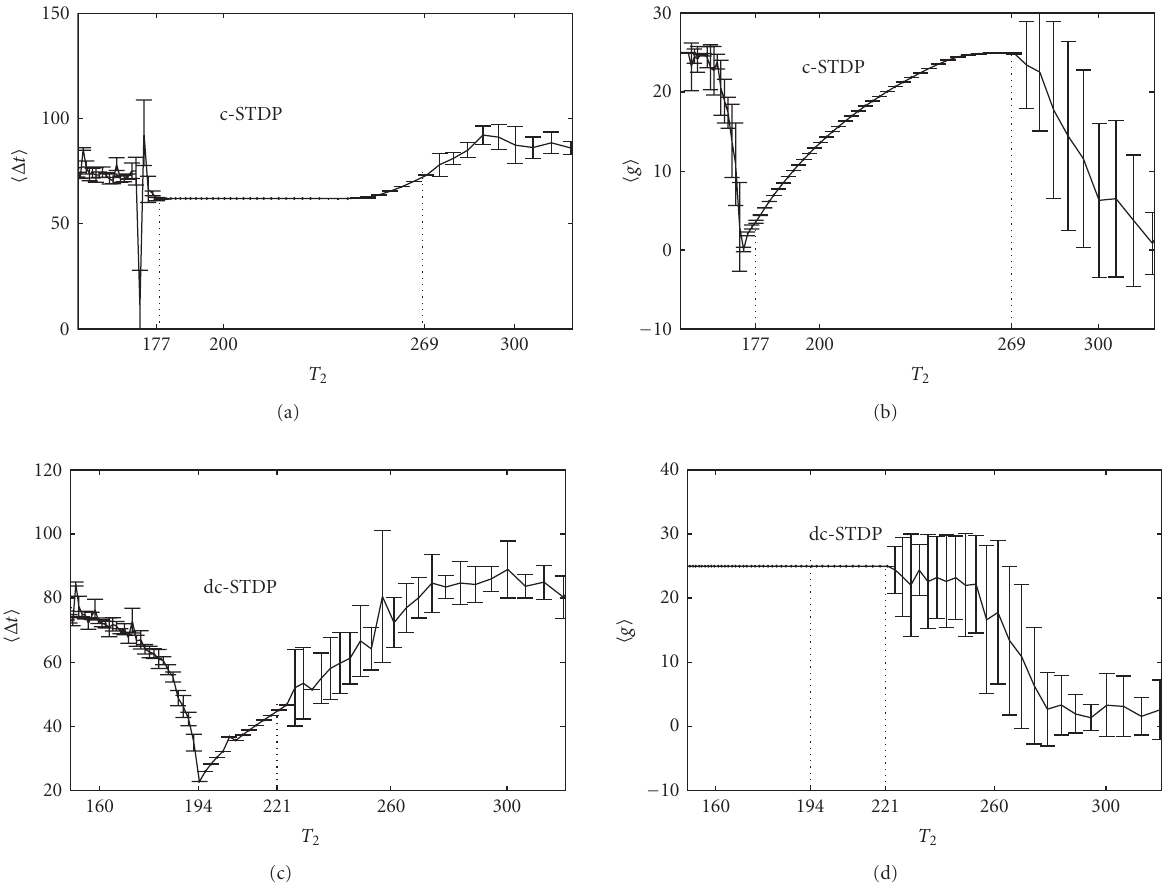
Figure 7: Four pictures are obtained from the same values of parameters and model of Figure 3. The front four pictures take the function of tanh to limit synaptic strength for c-STDP and dc-STDP rules. Figures 7(a) and 7(c) show the average spike time interval of postneuron’s and preneuron’s spike time for c-STDP and dc-STDP over some time after a period time of coupling, respectively. Figures 7(b) and 7(d) present the average synaptic strength for c-STDP and dc-STDP rule, respectively. Each subplot has two dash lines what indicate the boundary of synchronization